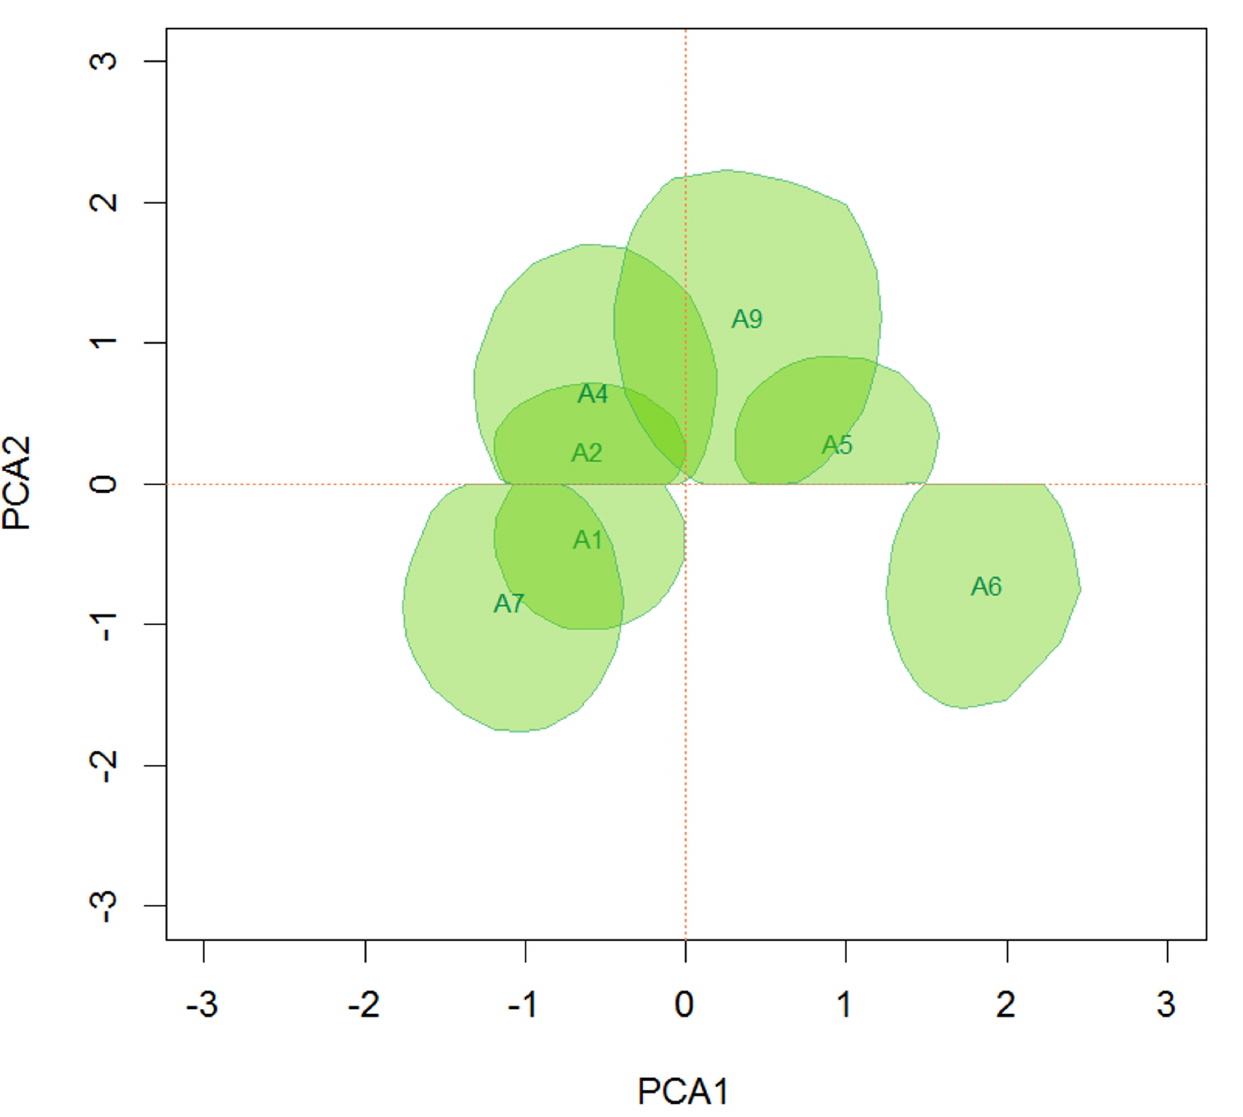
Fig 12. 95% credible regions that do not include the origin for the first two principal axis of the environmental